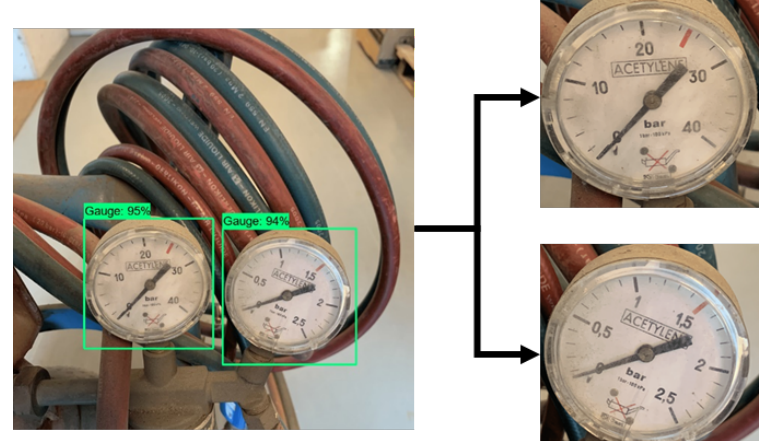
Figure 5. Gauge detection implementation.